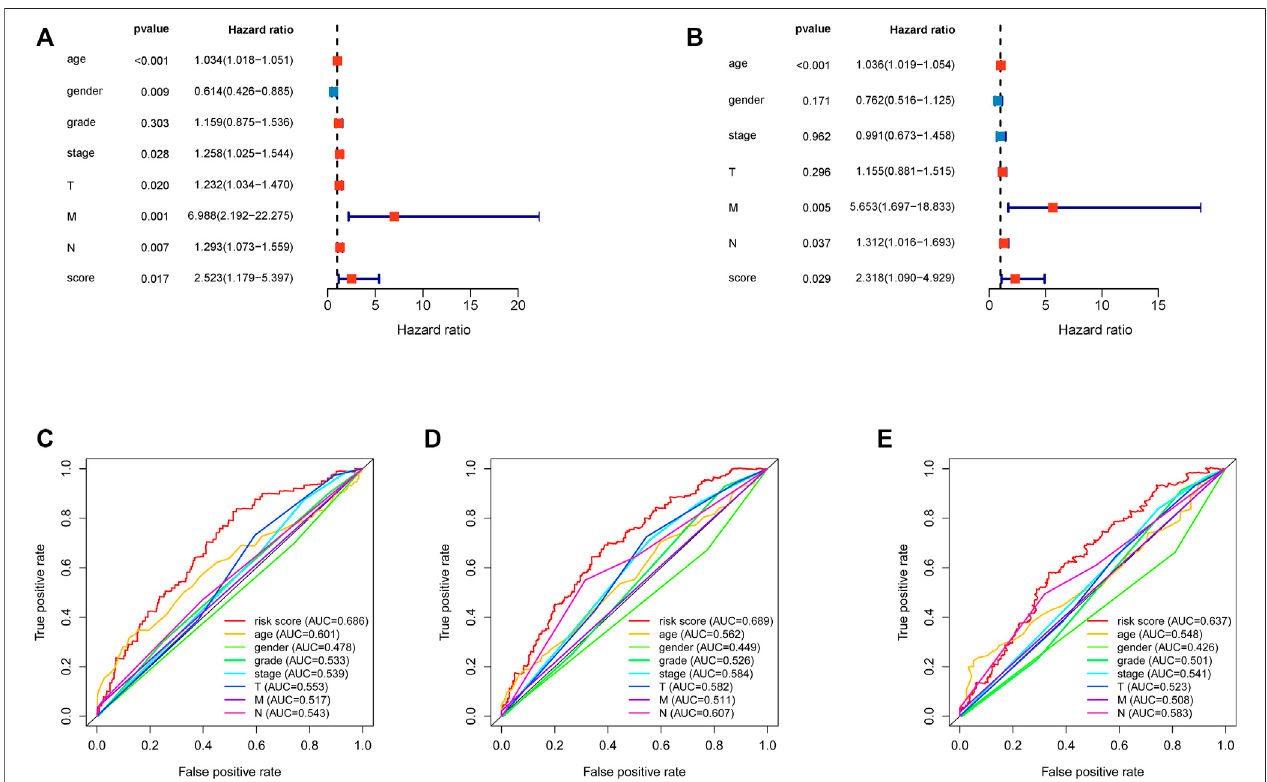
FIGURE 4 | Assessment of the independence of the HNSCC prognostic model and comparison between risk score and clinical features. (A) . Univariate analysis Cox regression analysis con fi rmed the independence of the prognostic model. (B) . Multivariate Cox regression analysis con fi rmed the independence of the prognostic model. HNSCC, head and neck squamous cell carcinoma. (C) . 1 year multiROC curve of risk score and clinical features. (D) . 3 year multiROC curve of risk score and clinical features. (E) . 5 year multiROC curve of risk score and clinical features.